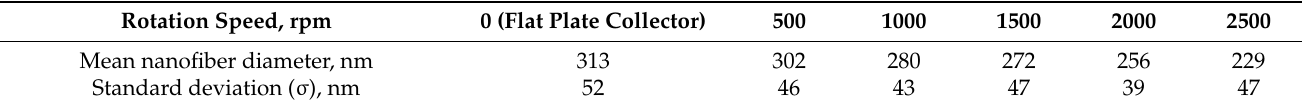
Table 1. The dependence of the mean nanofiber diameter on the rotation speed of the collector. Rotation Speed, rpm